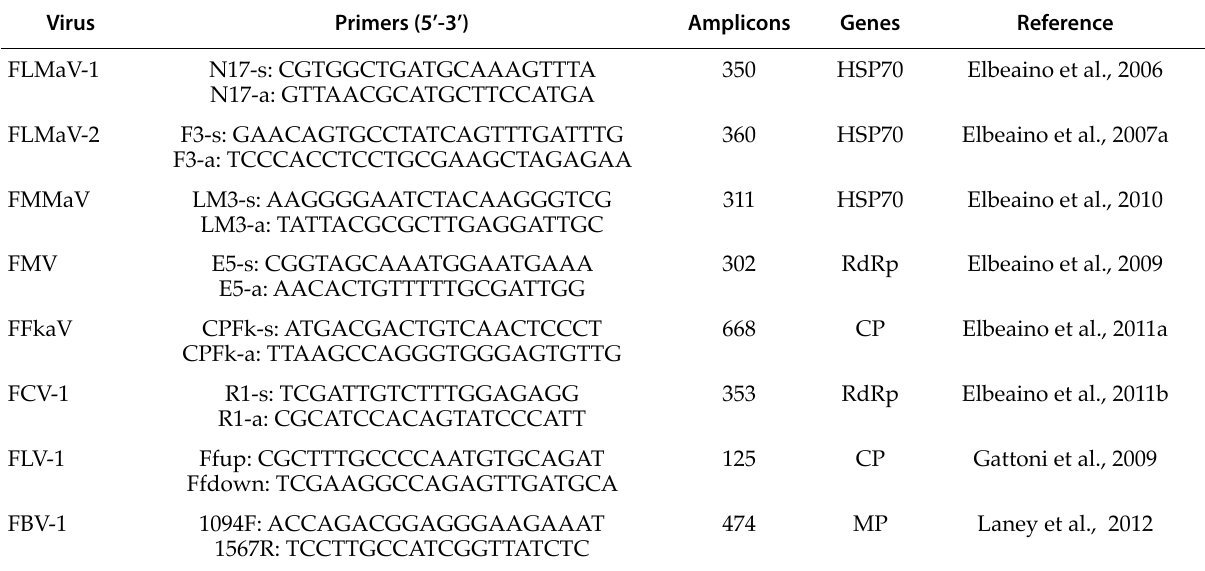
Supplementary Table 1. List of primers used in RT\PCR assays for Fig leaf mottle-associated virus 1 (FLMaV-1), Fig leaf mottle-associated virus 2 (FLMaV-2), Fig mild mottle-associated virus (FMMaV), Fig mosaic emaravirus (FMV), Fig fleck- associated virus (FFkaV), Fig latent virus 1 (FLV-1), Fig cryptic virus 1 (FCV-1), Fig badnavirus 1 (FBV-1) detection. HSP70,